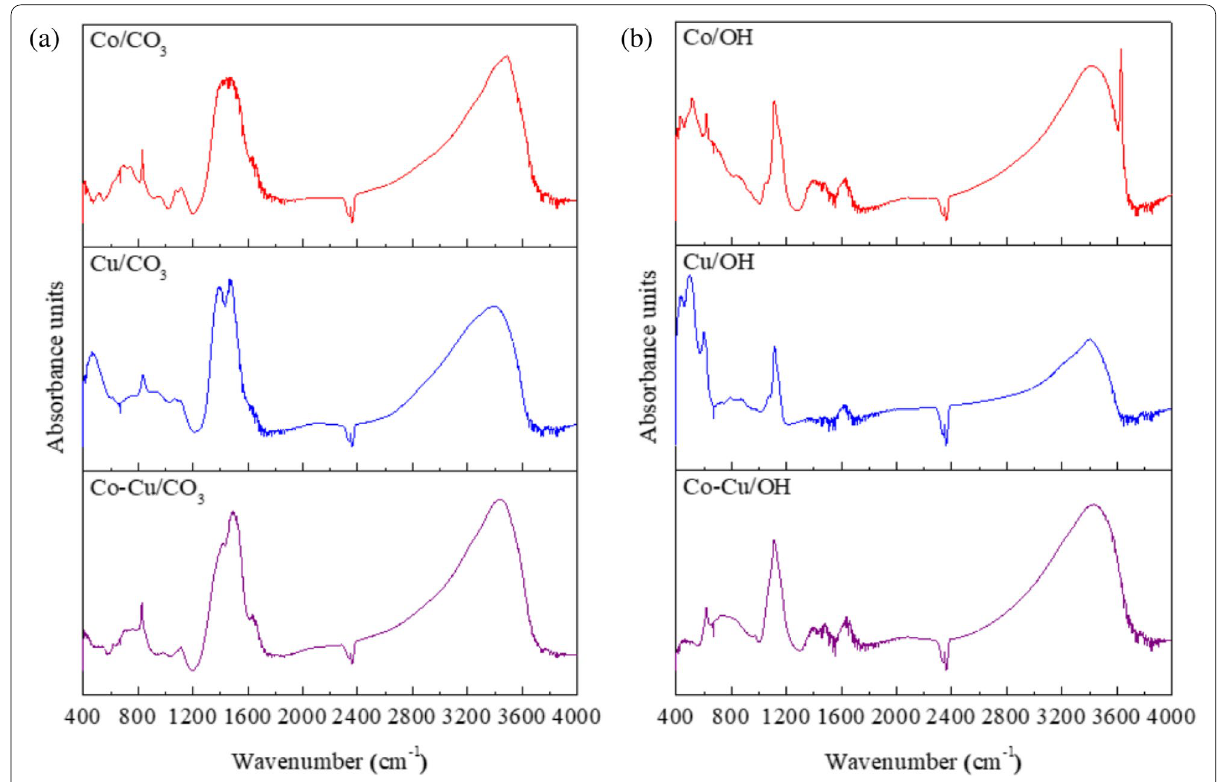
Fig. 15 FTIR spectra of carbonate and hydroxide precipitates at pH 10